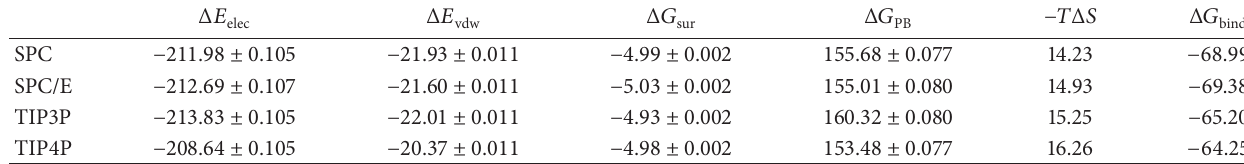
Table 4: The same as in Table 3 but for OPLS-AA/L force field.